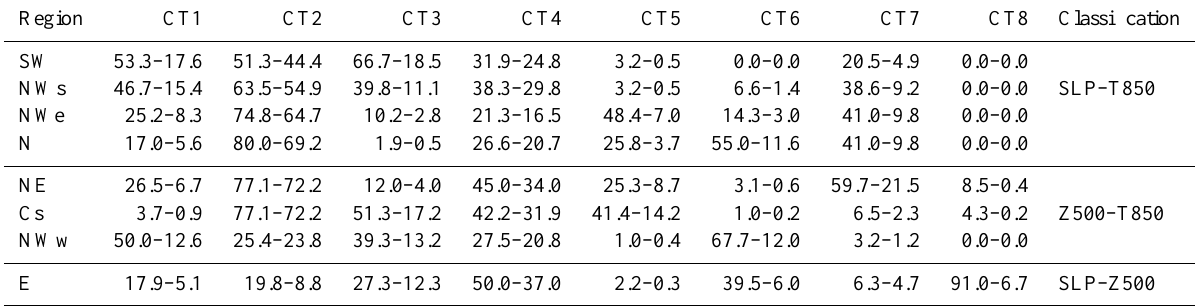
Table 4. Efficiencies before and after the allocation process (in percentage) for the CTs of the best classification (last column) for each region. Region